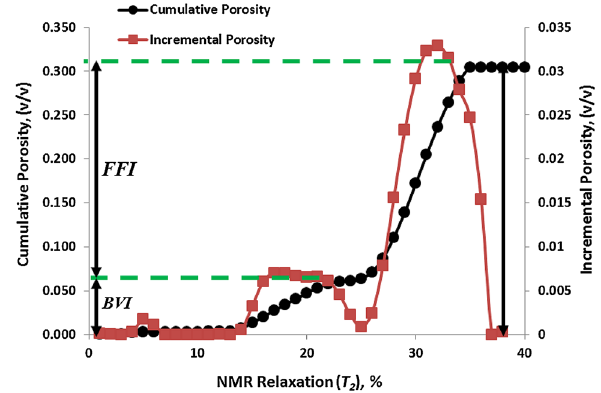
Fig. 17 Measured capillary pressure (black) and NMR derived capil- lary pressure (red) for the mud rich thin bed unit indicating a poor